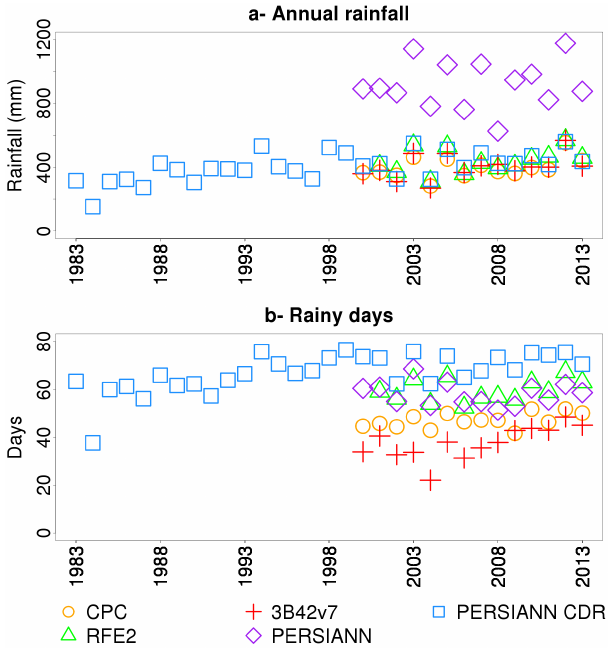
Figure 2. Annual rainfall accumulation (a) and number of rainy day (b) for PERSIANN-CDR (1983–2013) and other products (2000–2013) over the study